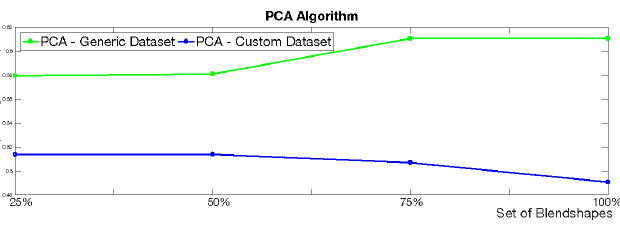
Fig. 19. Graph showing the error difference between the generic dataset and customized dataset processing for the PCA